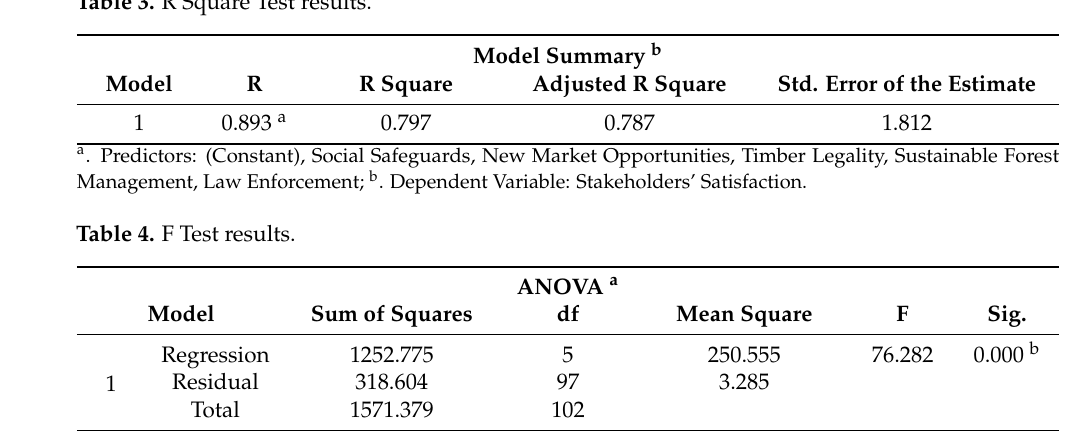
Table 3. R Square Test results.